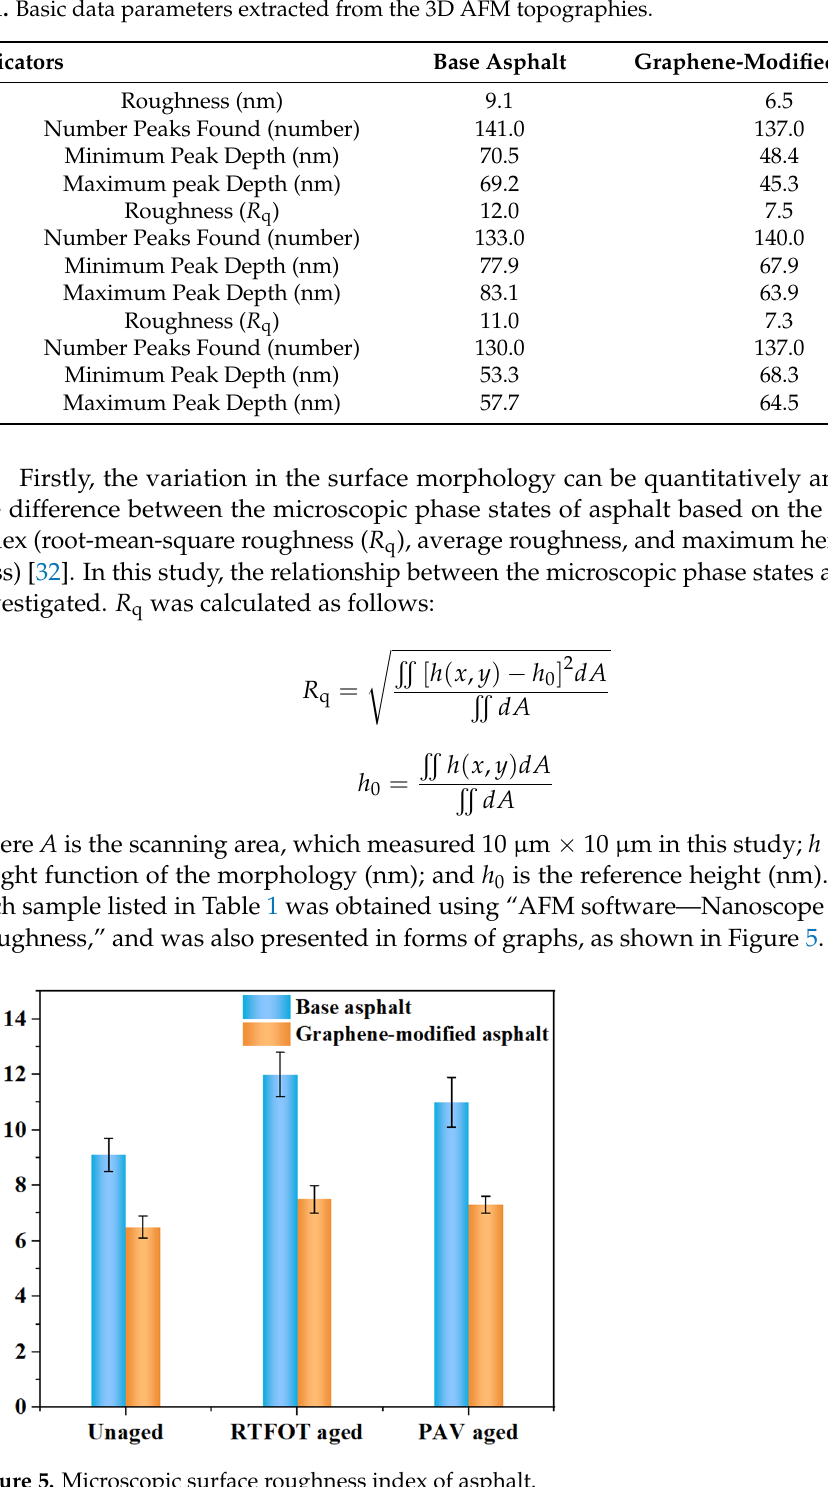
Figure 5. Microscopic surface roughness index of asphalt.